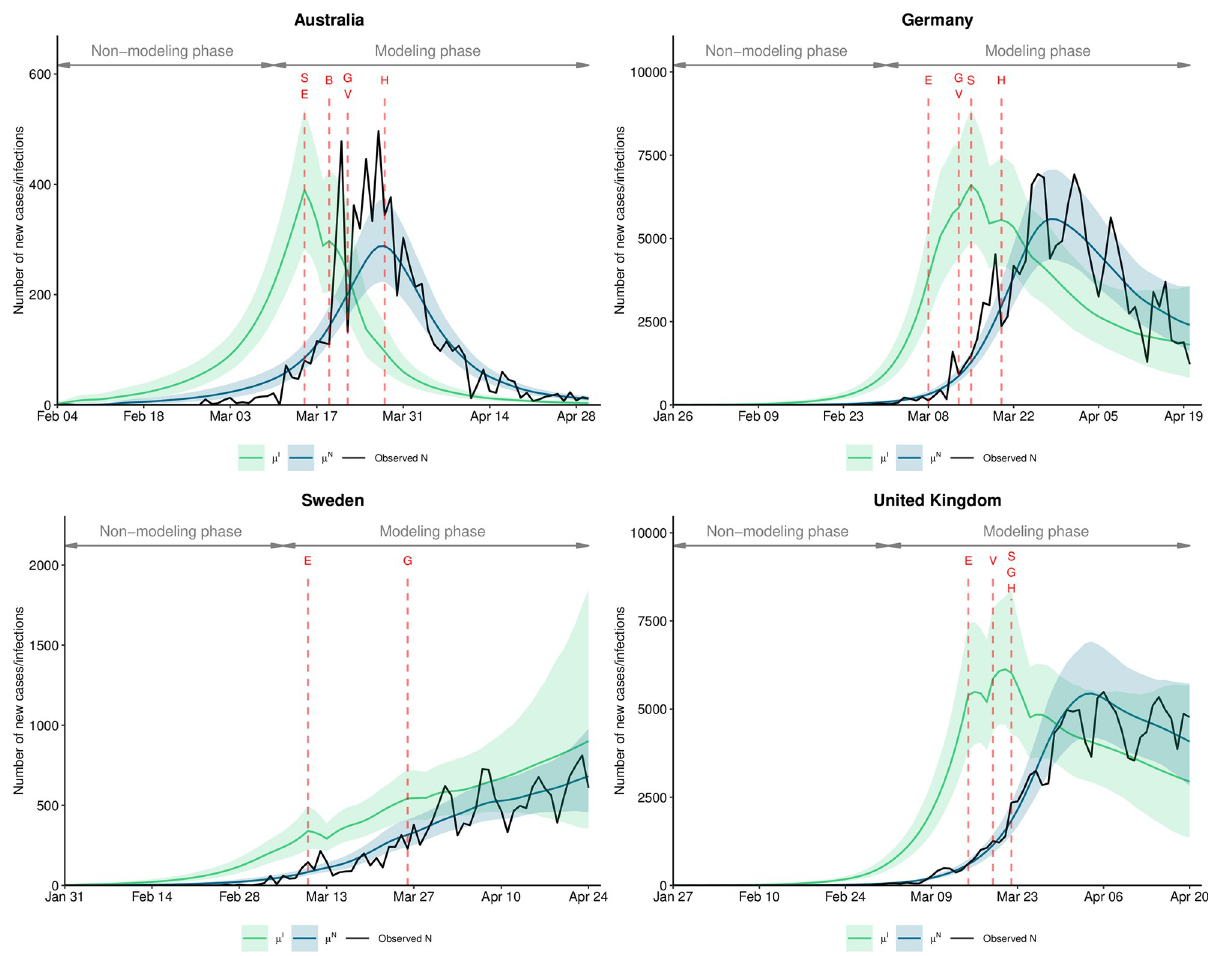
Fig 6. Model fit for four selected countries over time. Expected number of new infections μ I and new cases μ N (posterior mean as colored lines with 95% credible interval as shaded area) and the observed number of new cases by country over time. Red letters and lines indicate the first day an NPI was implemented within a country (S: School closures, B: Border closure, E: Ban of large gatherings, G: Ban of small gatherings, V: Venue closure, H: stay- at-home order, W: Work-from-home order). The non-modeling phase is the time period before 100 cumulative cases were observed, which was used to seed infections in the early outbreak of the epidemic. Plots for all countries are provided in Section 7 in S1 Appendix.